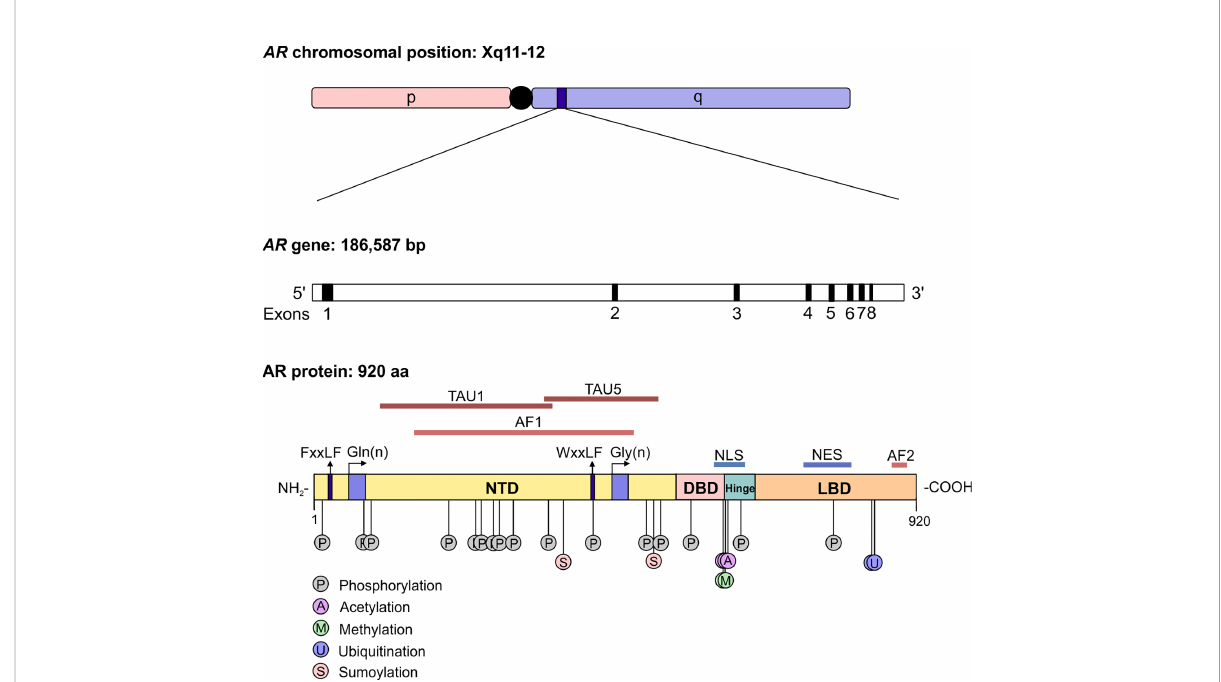
FIGURE 2 The structure of the androgen receptor gene and protein. The AR gene is situated on position q11-12 of chromosome X and contains 8 exons. The protein reference sequence NM_000044.3 is comprised of 920 amino acids and is composed of different domains which are depicted. In addition, posttranslational modi fi cations known to in fl uence AR function are shown. AR, androgen receptor; bp, base pair; NTD, N-terminal domain; DBD, DNA binding domain; LBD, ligand binding domain; AF, activation function; TAU, transcription activation unit; NLS, nuclear localisation signal; NES, nuclear export